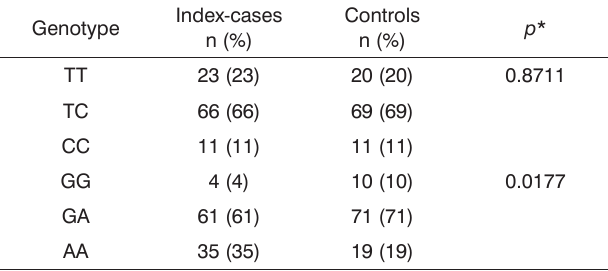
Table 3. Distribution of genotypes in index cases and controls for T102C and -1438G/A polymorphisms of the 5-HTR2A gene. Genotype